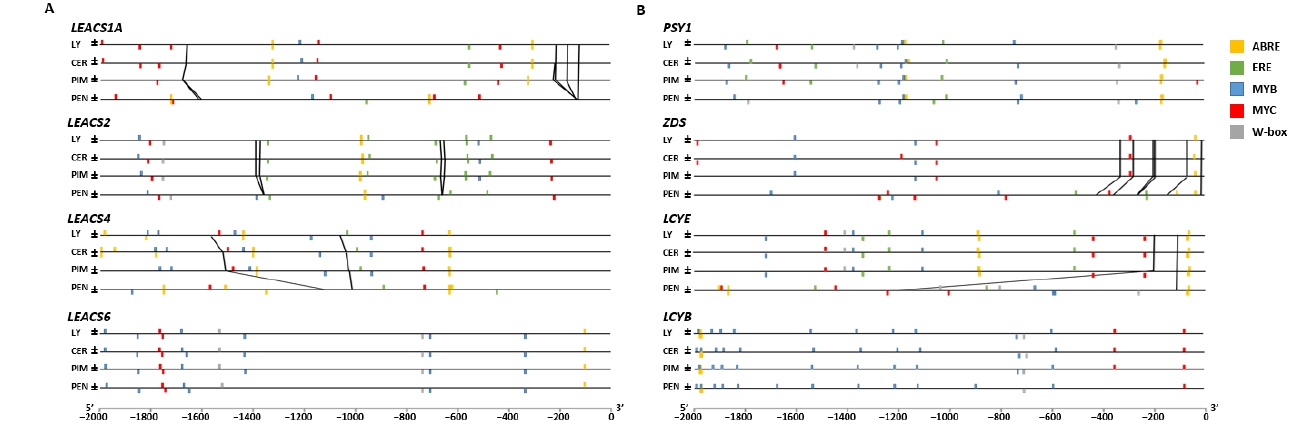
Figure 3. In silico analysis of cis-regulatory elements. Regulatory elements are found at upstream sequences of ethylene biosynthetic genes ( A ) and carotenoid biosynthetic genes ( B ). Insertions and deletions at the regulatory sequences are connected by black lines. Yellow bars, ABA-responsive element (ABRE); green bars, ethylene-responsive element (ERE); blue bars, MYB protein-binding domain (MYB); red bars, MYC family protein-binding domain (MYC); gray bars, WRKY TF-binding domain (W-box). LY, S. lycopersicum ; CER, S . lycopersicum var. cerasiforme ; PIM, S. pimpinellifolium ; PEN, S. pennellii .